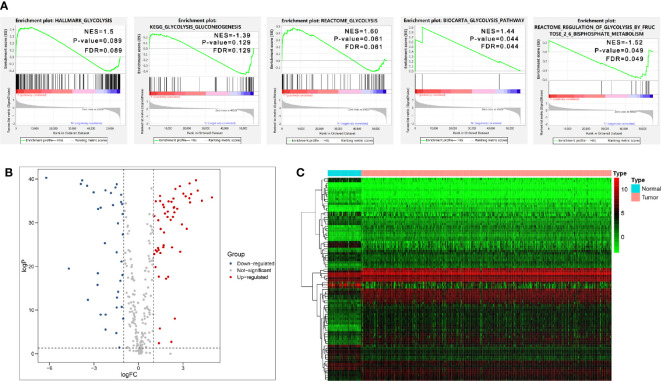
Initial screening of genes by GSEA and differential expression analysis. (A) GSEA results of the five glycolysis-related gene sets. (B, C) Volcano Plot and heat map of differential expression of glycolysis-related genes between ccRCC tissues and normal renal tissues.